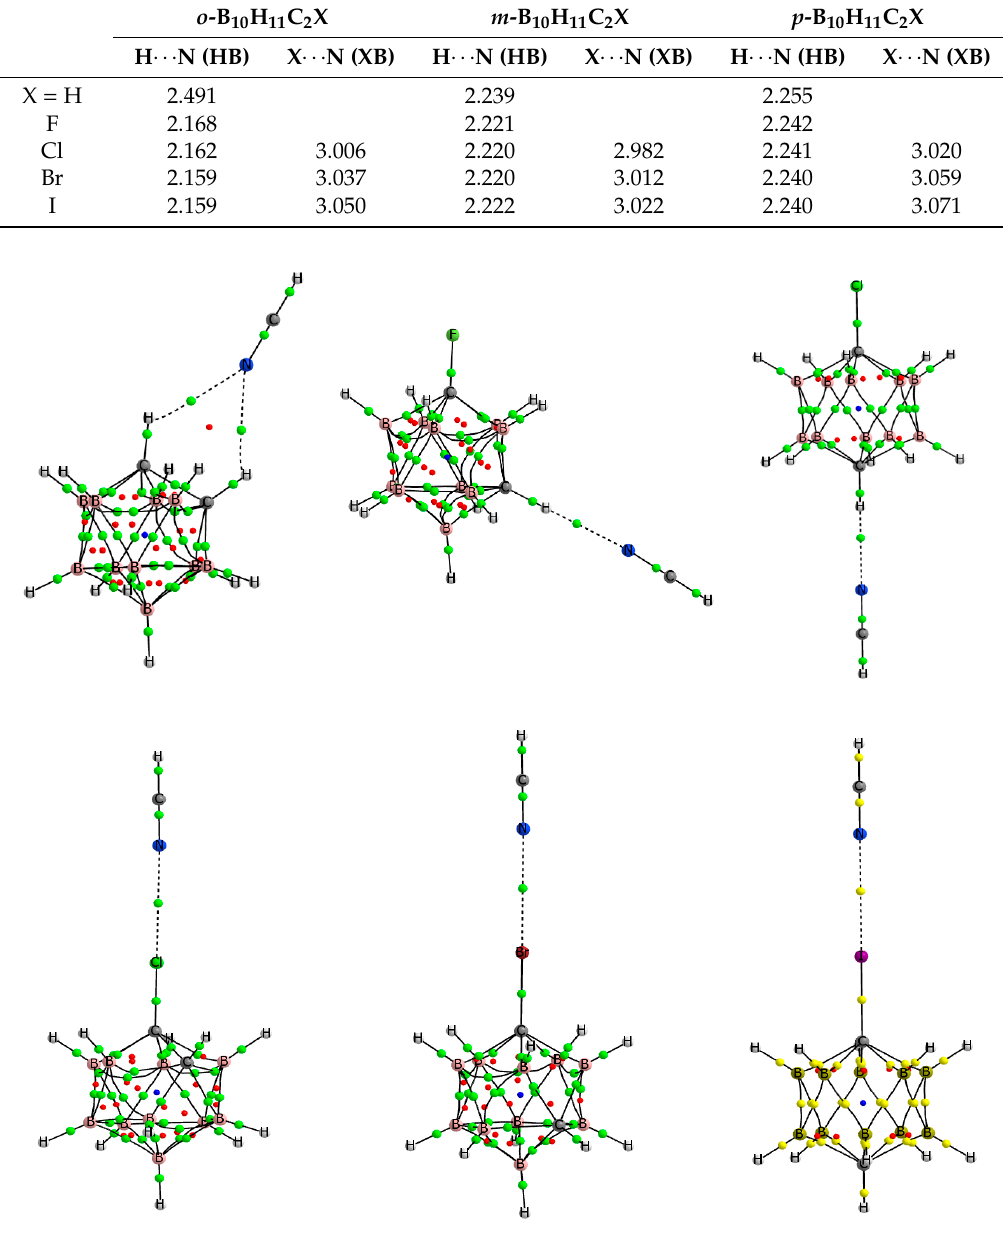
Figure 3. Molecular graph of some of the hydrogen- and halogen-bonded complexes between 1-halo- closo -carboranes and NCH. The locations of the bond, ring and cage critical points are indicated with green, red and blue dots, respectively.